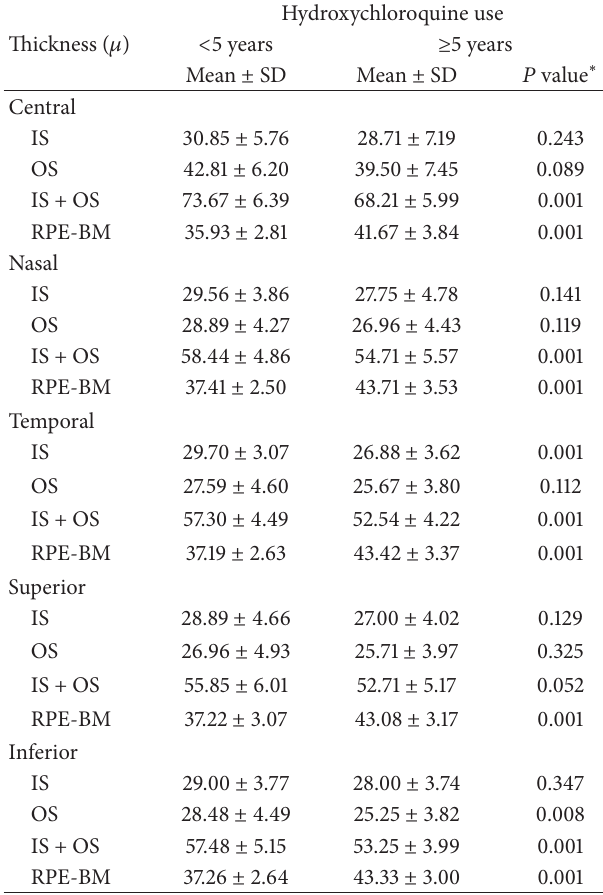
Table 4: Comparison of SD-OCT image segmentation values in subgroups based on the duration of hydroxychloroquine